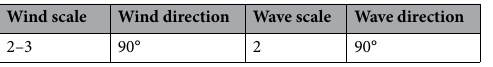
Table 2. Parameters of the marine environment loads.